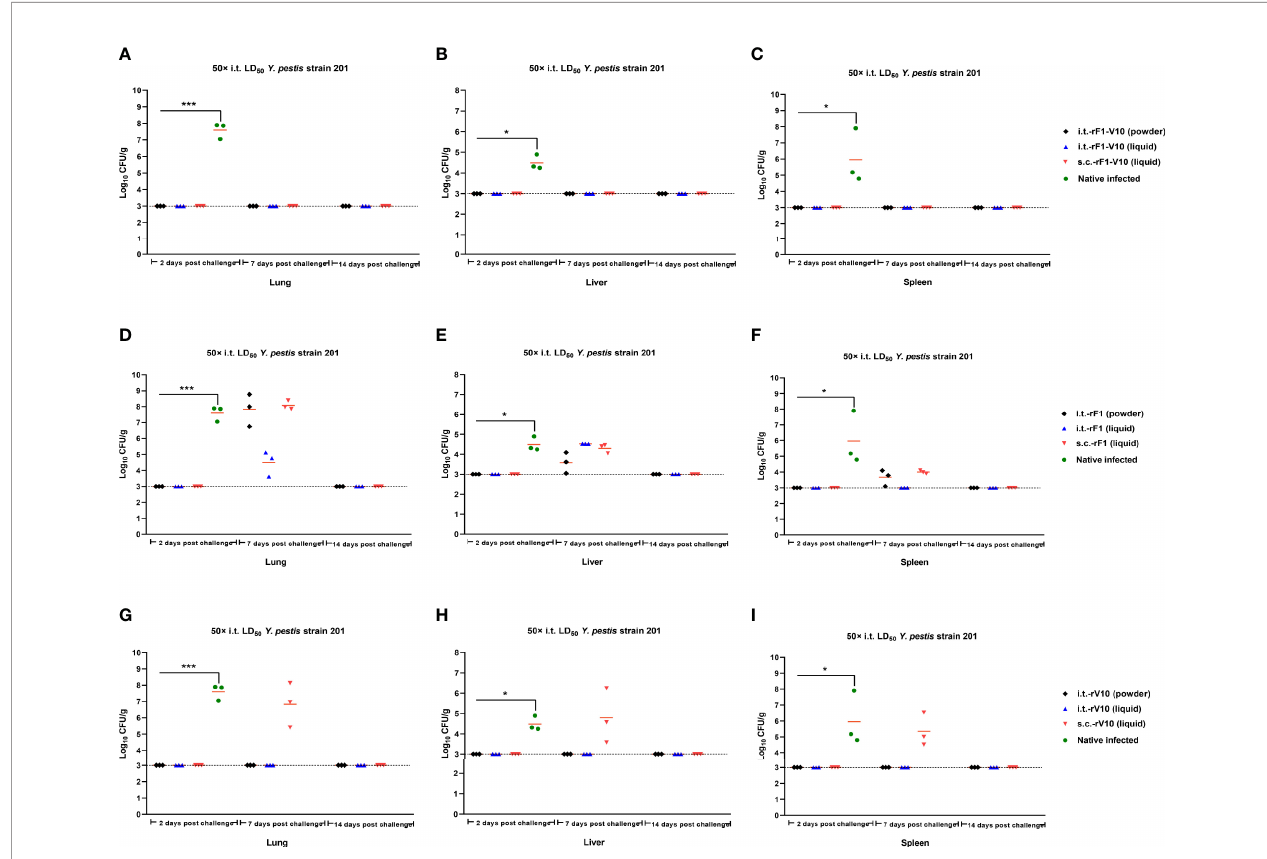
FIGURE 6 | Bacterial load in the organs of mice euthanized at days 2, 7, and 14 post 50× LD 50 of Y. pestis strain 201 i.t. challenge. (A – C) Bacterial load in (A) lungs, (B) liver, and (C) spleen of mice immunized with rF1-V10 dry power and liquid formulations. (D – F) Bacterial loads in (D) lungs, (E) liver and (F) spleen of mice immunized with rF1 dry power and liquid formulations. (G – I) Bacterial loads in (G) lungs, (H) liver and (I) spleen of mice immunized with rV10 dry power and liquid formulations. Experiments were performed twice independently with similar results. Data are expressed as the mean ± SD (n = 3) using data collected from one representative experiment. * P < 0.05; *** P <